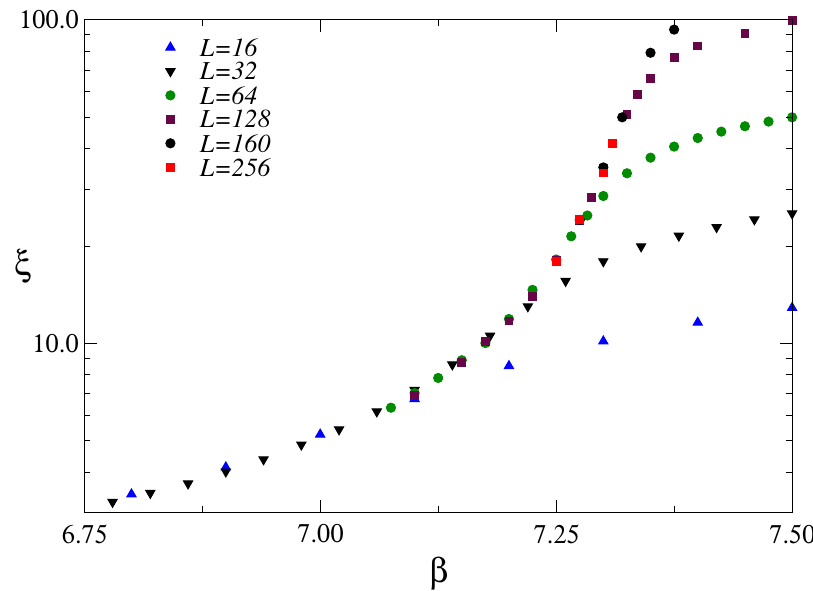
Figure 1 . Estimates of ξ versus β for N c = 3 , N f = 3 , v = 0 , and γ = 0 . Results for several values of L up to